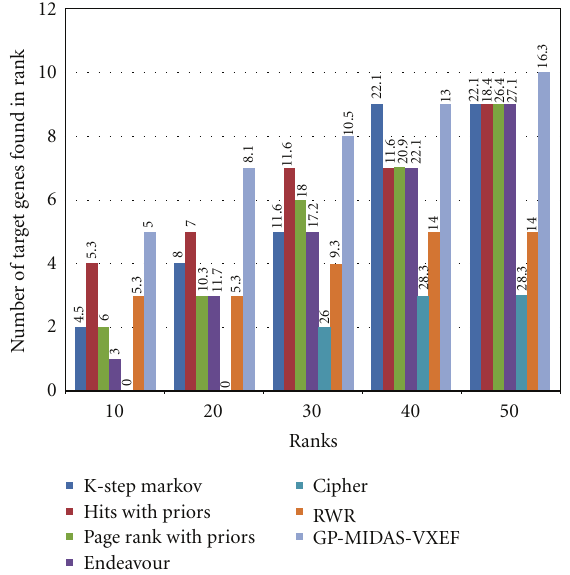
Figure 4: Target genes retrieved. Showing the amount of target genes retrieve on di ff erent ranks, on top of each bar the average po- sition of the found genes is shown.